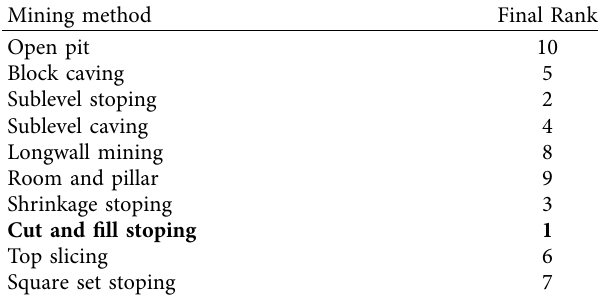
Table 8: Ranking of all mining methods using